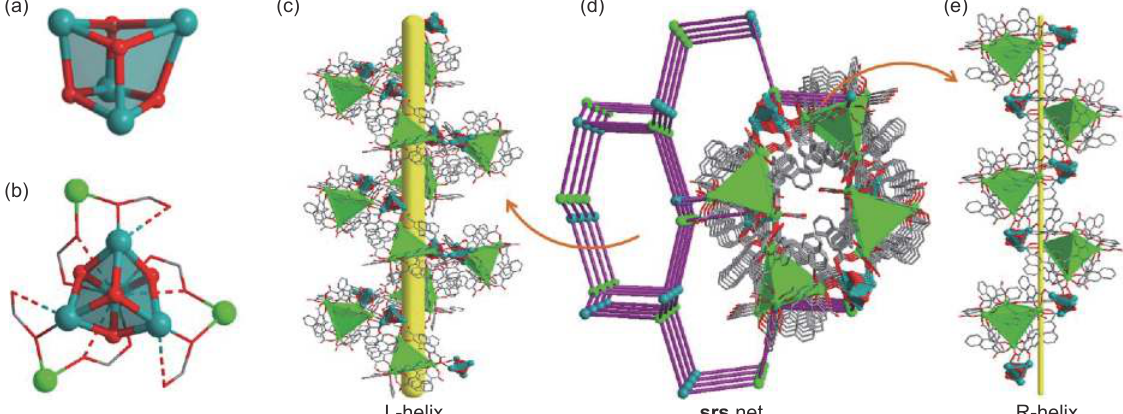
Figure 1 (a) and (b) Pb4 cluster building unit in PTC-290. (d) The 3-connected srs network of PTC-290, and (c) and (e) two helix chains. Hydrogen atoms have been deleted for clarity. Atom color code: green, Ti; olive, Pb; red, O; blue, N; gray,